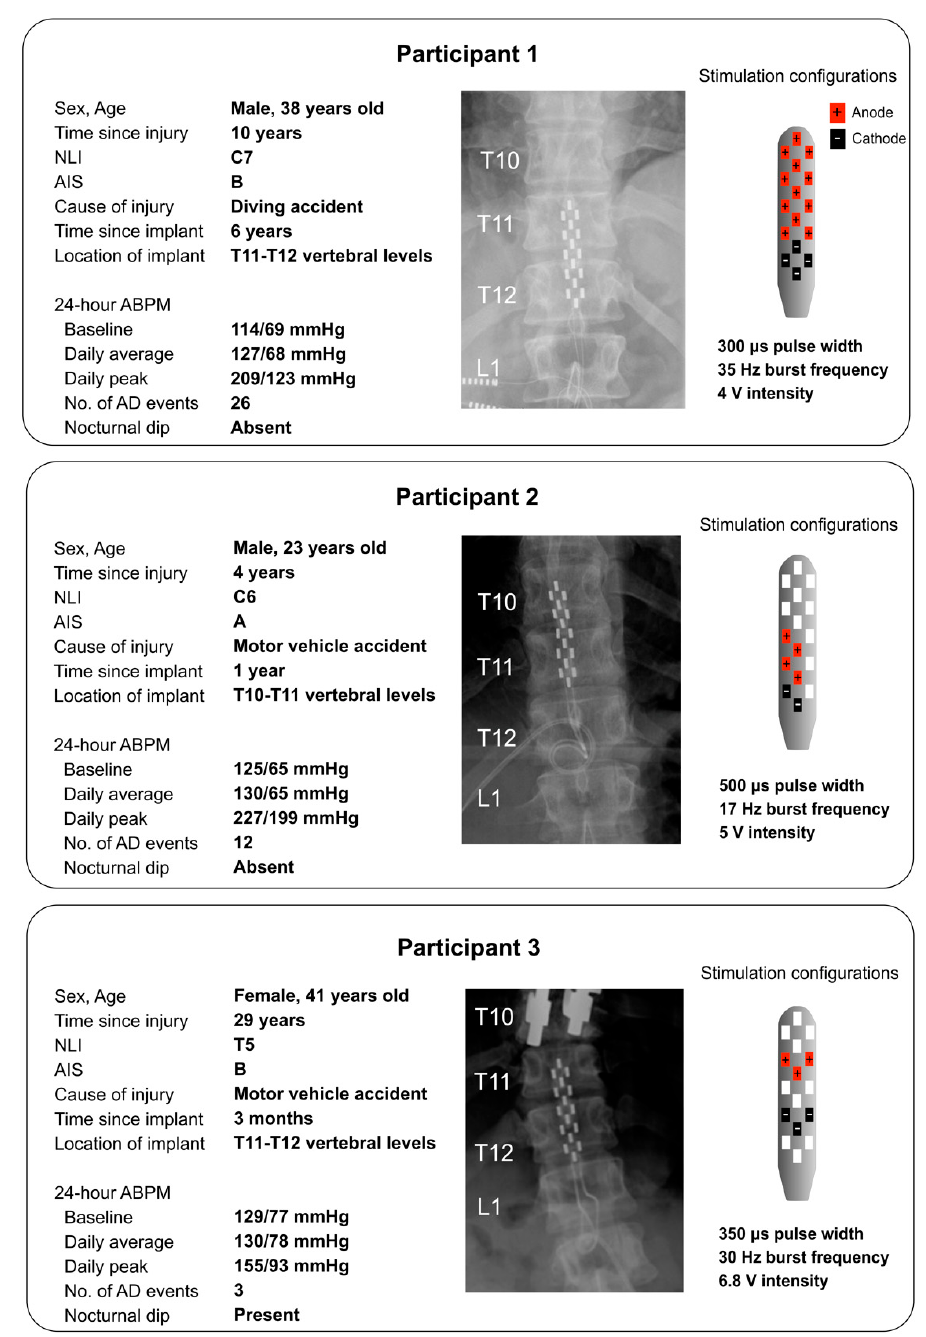
Figure 1. Demographics, blood pressure responses, epidural implant location and stimulation configuration, including active anodic and cathodic electrodes on the implants in three individuals with SCI. Anatomical placement of the 16-electrode array: conventional radiography of the thoracic and lumbar spines displays the position of the 16-electrode array. Stimulation configurations: red identifies anodes and black identifies cathodes. Cathodes were the caudal electrodes in all participants. Abbreviations: ABPM, ambulatory blood pressure monitoring; AD, autonomic dysreflexia; AIS, American Spinal Injury Association Impairment Scale; BP, blood pressure; C, cervical; DBP, diastolic blood pressure; Hz: hertz; SBP, systolic blood pressure; us, microseconds; V,